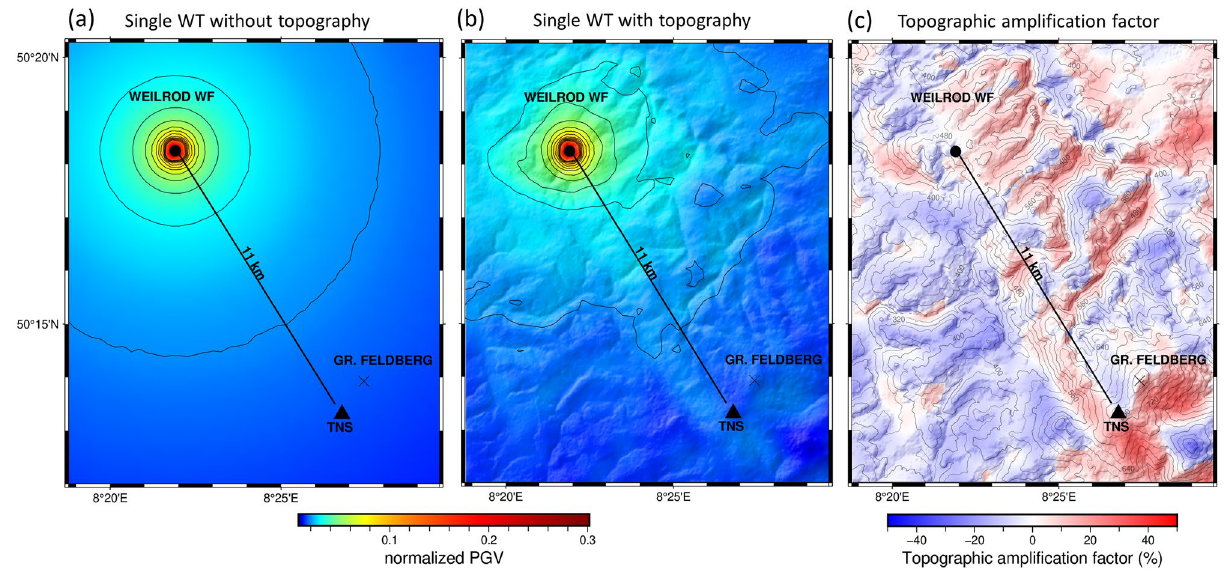
Figure 3. Peak ground velocity (PGV) maps without ( a ) and with ( b ) topography and the resulting map of the amplification due to topography ( c ) for a single WT at the centre of the Weilrod WF showing that the amplitude increases at the permanent station (TNS). The amplitudes in ( a ) and ( b ) are normalized to the maximum amplitude in Fig. 4c (with 7 WTs), to compare the radiation of a single and multiple WTs. Note: The contour lines in ( c ) are representative of the digital elevation